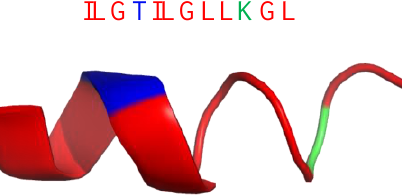
Figure 25. Secondary structure of protonectin (PDB: 6N68). In blue: hydrophilic amino acids; in green: positively charged amino acids; in red: hydrophobic amino acids.